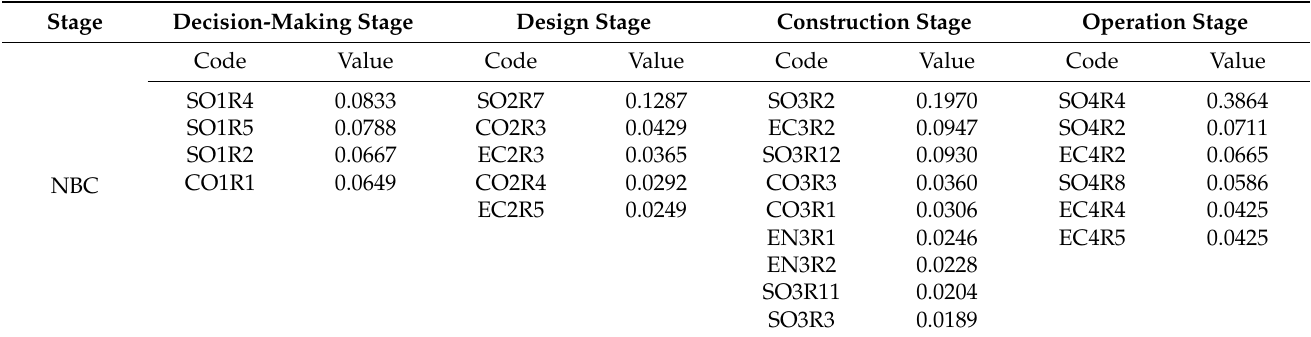
Table 6. Betweenness centrality key